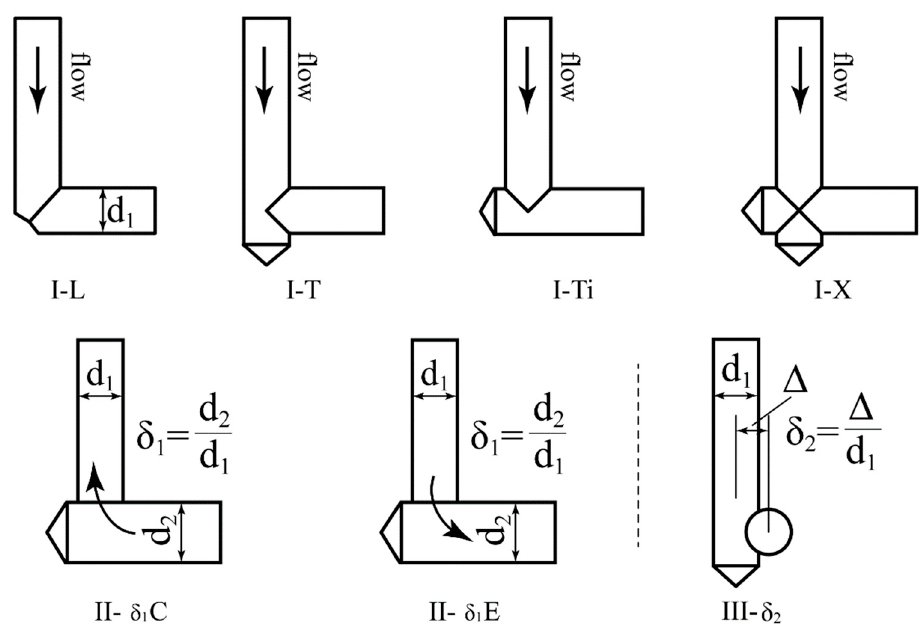
Figure 1. Typical passages in a manifold.